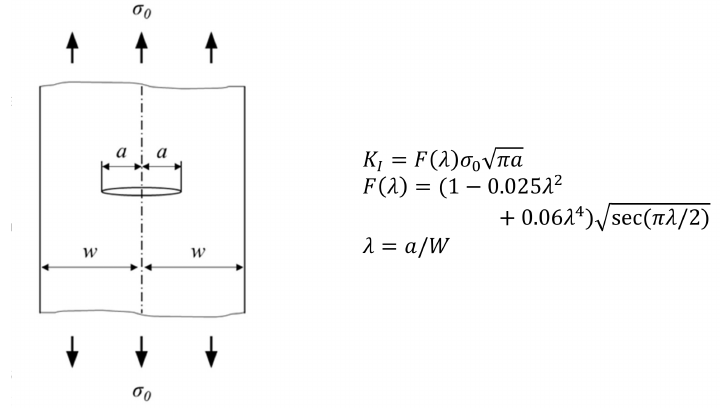
Figure A3. Centre crack in a strip